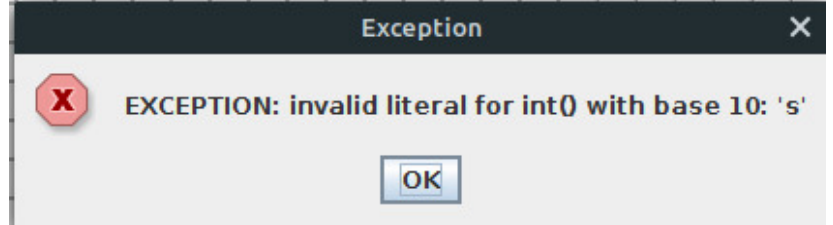
Figure 10. Exception popup.